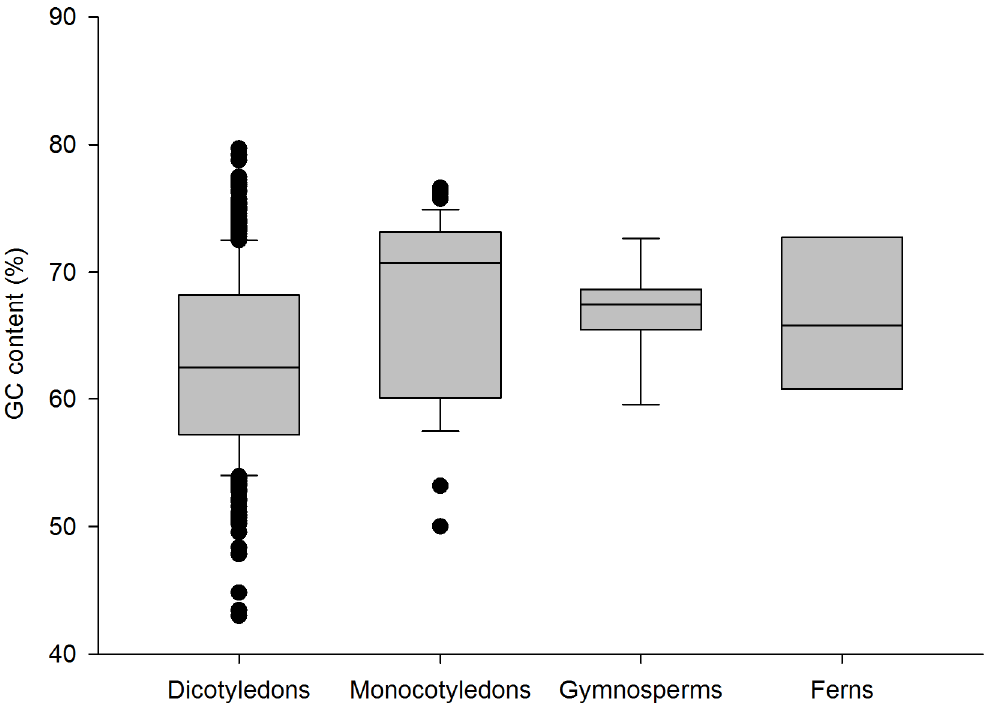
Fig 3. Box plots of the GC contents of ITS2 barcodes of southern herbs. The box plot illustrates the IQR of the data. The IQR is defined as the difference between the 75th percentile and the 25th percentile. The line through the box represents the median GC contents.